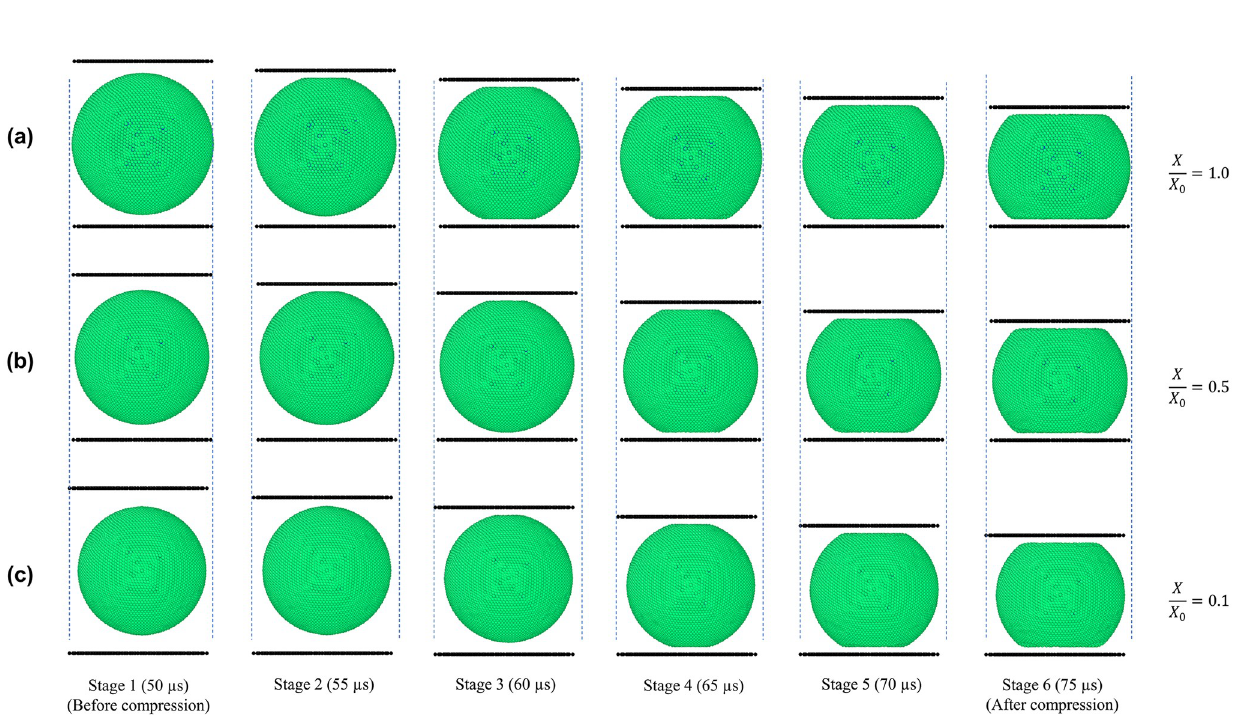
Fig 3. Depiction of gradual compression of dried cells as predicted by the 3-D SPH-CG model. (a) fresh cells ( X/X (c) dried cells ( X/X 0 = 0.1) ( X/X 0 is the normalised moisture